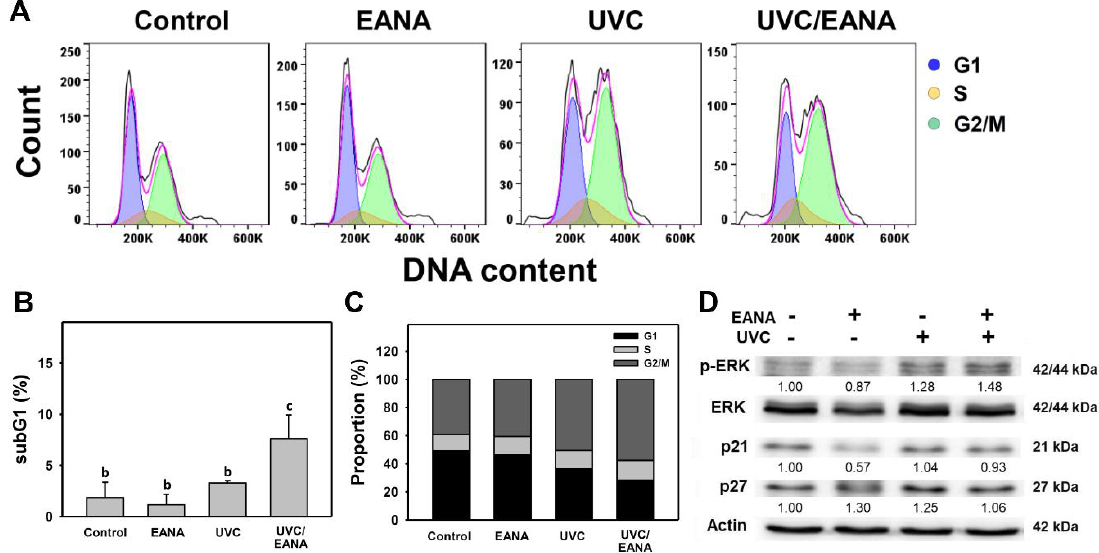
Figure 2. Cell cycle analysis of EANA and/or UV treatments for human oral cancer Ca9-22 cells. With or without NAC (10 mM) pretreatment for 1 h, cells were post-treated with control (DMSO only), EANA (5 µg/mL), UVC (12 J/m 2 ), and combined treatment (UVC/EANA) for 24 h. ( A ) Typical flow cytometry patterns for cell cycle. ( B , C ) Statistical analysis for subG1 and cell cycle phases in Figure 2A. Treatments showing no overlapped labels (a–c) differ significantly between multiple comparisons ( p < 0.05–0.0001). Data, mean ± SD ( n = 3). ( D ) Western blotting analysis for p-ERK, ERK, p21, and p27. Intensity ratio for p-ERK was adjusted to ERK intensity. Intensity ratio for p21 and p27 was adjusted to actin intensity.